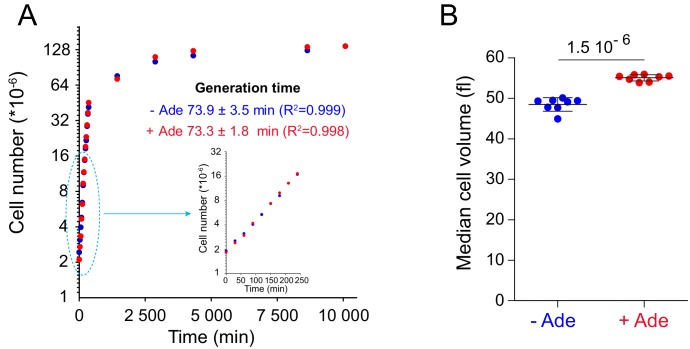
Adenine supplementation affects cell growth but not cell proliferation.(A) A prototrophic yeast strain (FY4) was exponentially grown for 24 hr in SDcasaWU medium ±Adenine as in Figure 2. Cultures were then diluted at 2 106 cells/ml and cell number was followed by using a Multisizer IV (Beckman Coulter). Generation time was determined with a non-linear growth fit (GraphPad Prism) on cells grown in the presence (red dots) or the absence (blue dots) of adenine (N = 2). (B) Median cell volume was determined on the independent exponentially grown cells (N = 8) used for the metabolic extraction presented in Figure 8A–D. Number on the top corresponds to the p-value calculated from a Welch’s t-test.10.7554/eLife.43808.007Figure 2—figure supplement 2—source data 1.Median cell volume for the FY4 prototrophic strain grown in glucose medium ±adenine.